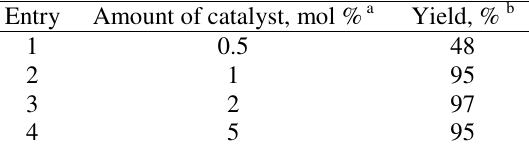
Table 1. Effect of Preyssler acid catalyst